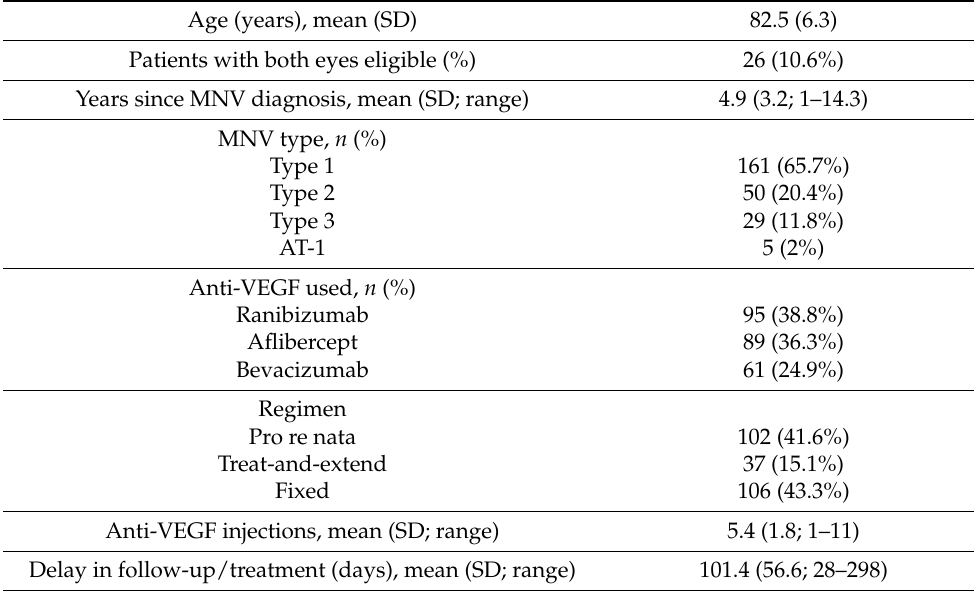
Table 1. Demographic variables assessed in AMD patients included in the study.